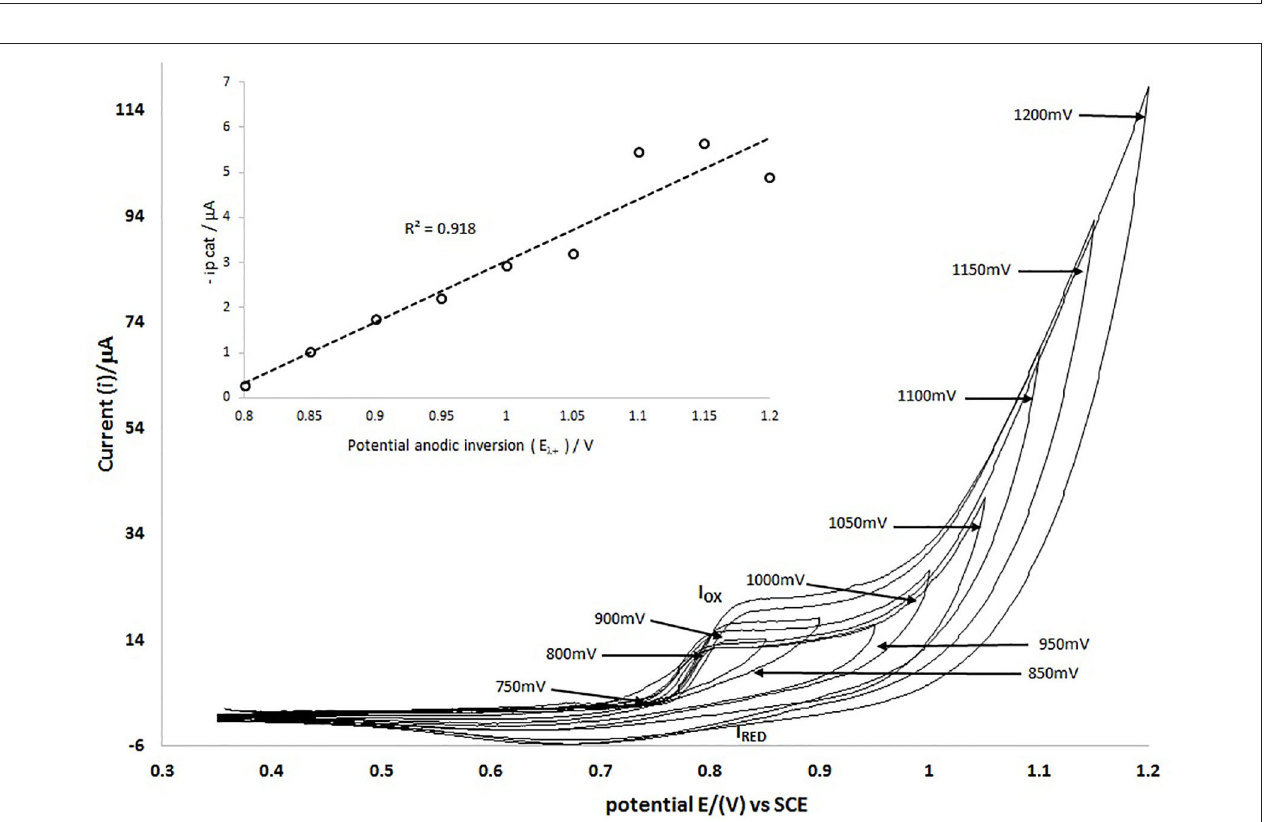
which may indicate that there are diffusion mechanisms in the